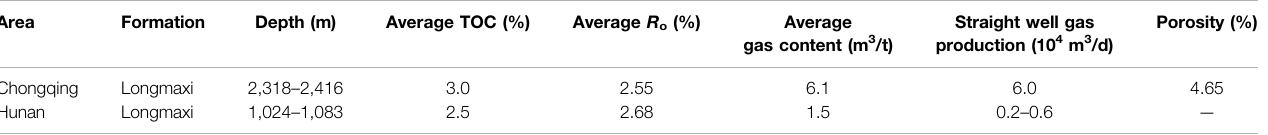
TABLE 1 | Reservoir parameters and gas content of the Lower Silurian Longmaxi shale in Chongqing and Hunan. Area